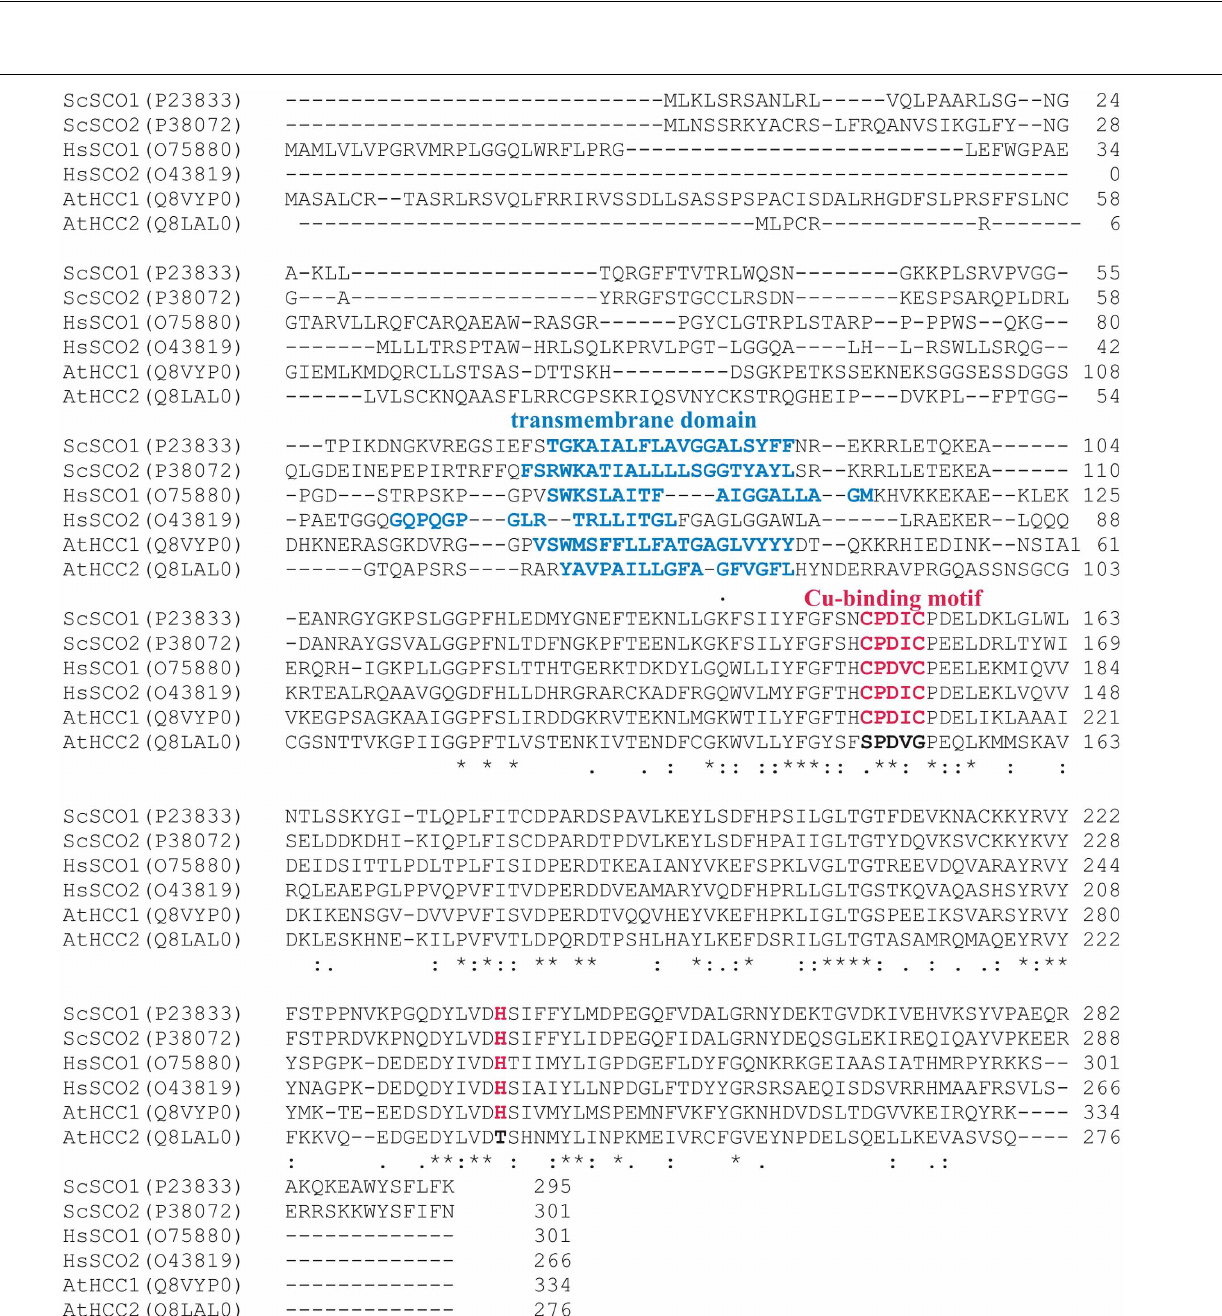
FIGURE 1 | Protein sequence alignment of SCO proteins from S. cerevisiae (ScSCO1 and ScSCO2), human (HsSCO1 and HsSCO2), and A. thaliana (AtHCC1 and AtHCC2). The alignment was performed with protein sequences from the UNIPROT database (accession codes are given) using the ClustalO 1.2.0 alignment tool (Sievers et al., 2011). The consensus sequence is shown below (“ ∗ ”